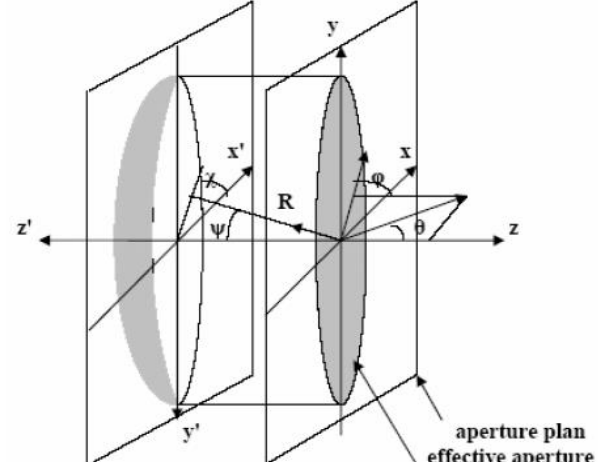
Figure 1: Geometry of parabolic reflector antenna and its projected effective antenna